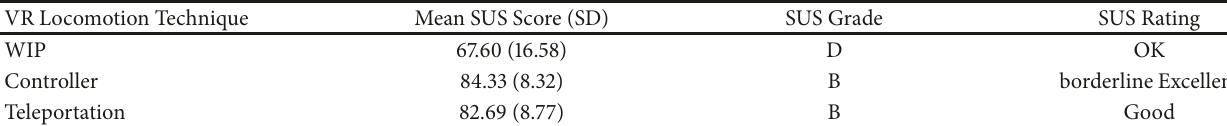
Table 2: The results of the SUS survey for the examined VR locomotion techniques.